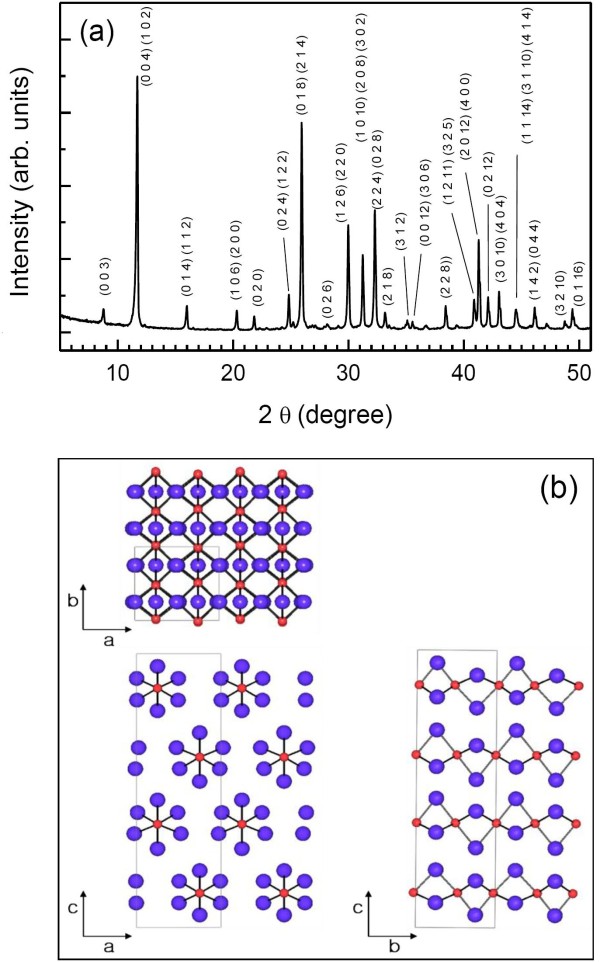
Powder XRD pattern (a) and crystal structure (b) of (CH3CH2NH3)PbI3. Red and purple spheres represent Pb and I ions, respectively.